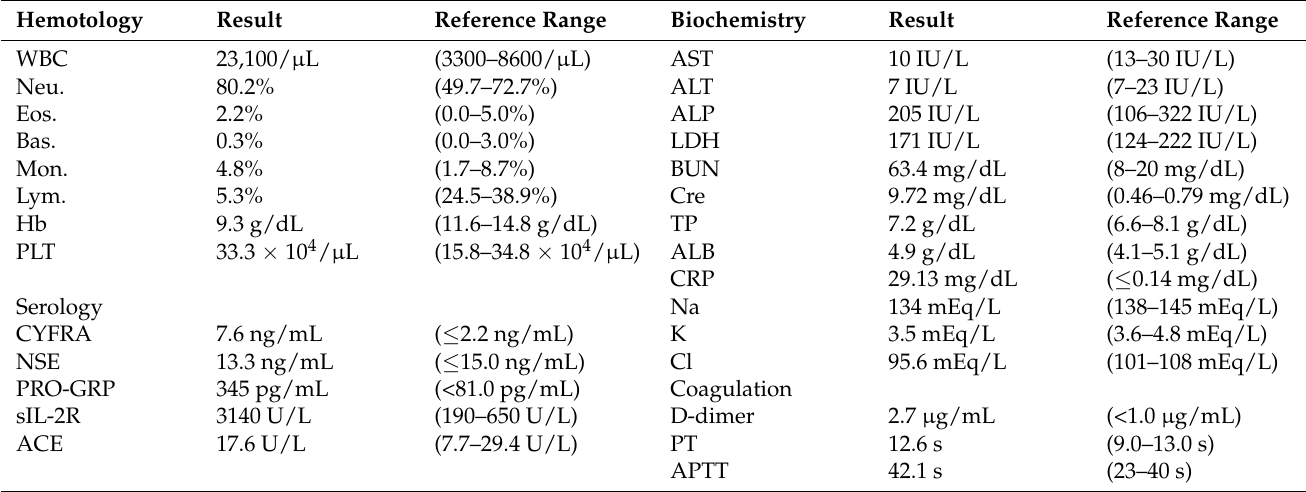
Table 1. Laboratory findings (data at the time of transfer to our